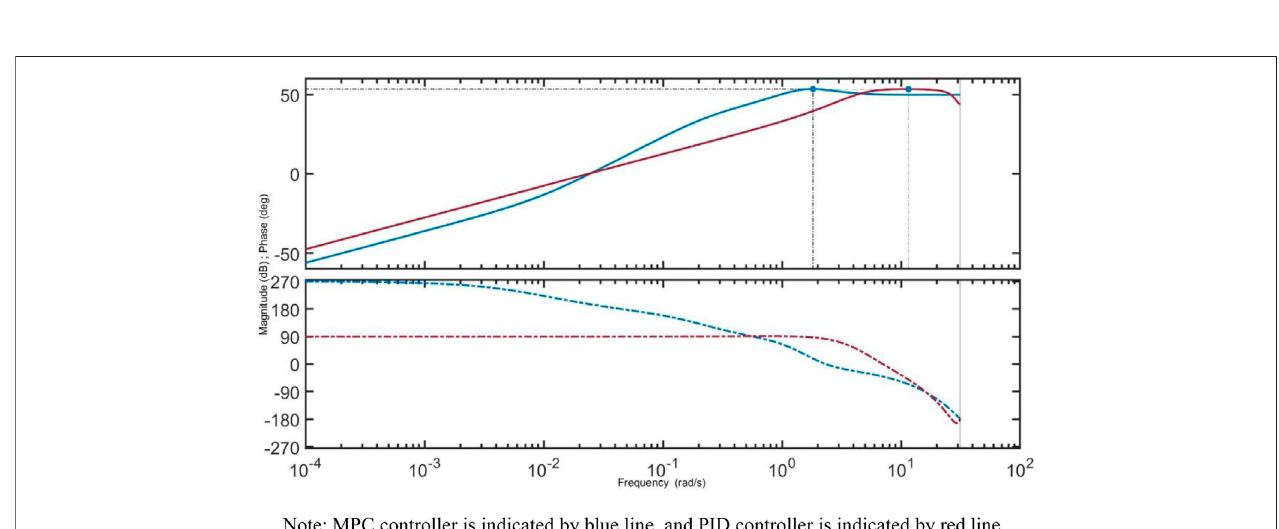
FIGURE 7 | Pole-Zero map of the core power control system. Note: MPC controller is indicated in the blue line, and PID controller is shown in the red line.